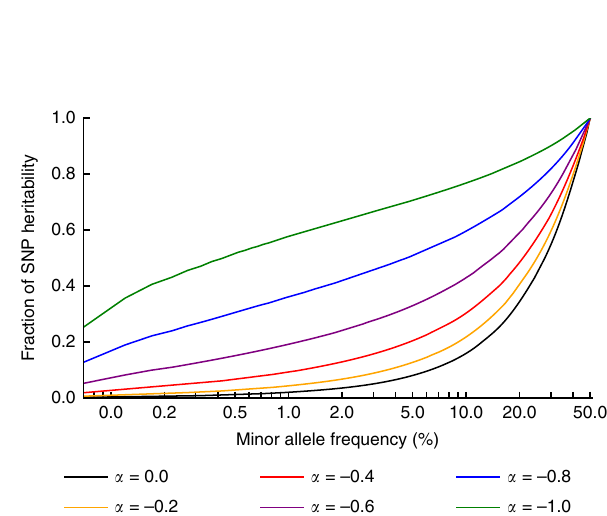
Fig. 1 Fraction of SNP-heritability in different MAF ranges given α .